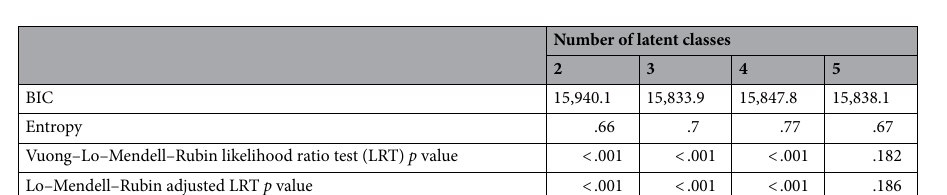
Table 2. Summarized model statistics for two- to five-class solutions of the latent class